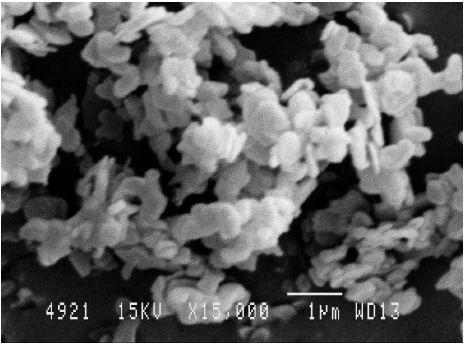
Figure 9. Hydrotalcite SEM.